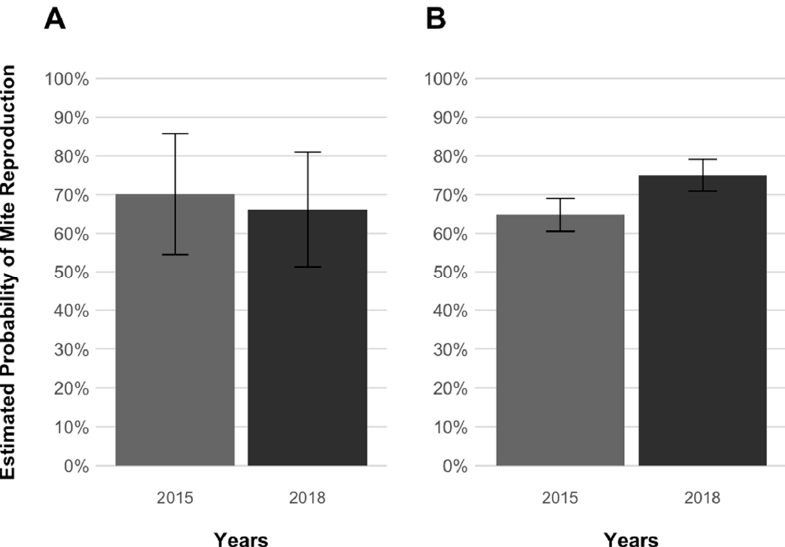
Figure 2. Temporal comparison of the estimated probabilities of reproduction ( ± SE) of female mites, Varroa destructor , from treated colonies in experimentally infested worker brood cells of Apis mellifera selected ( A ) and treated ( B ) colony groups. Earlier data (2015) from Panziera et al. [20] are in light grey and present data (2018) in dark grey. The earlier data refer to the groups AWD (treated-selected) and C (treated-treated) as reported in Panziera et al. [20]. No significant differences were detected between the estimated probabilities.